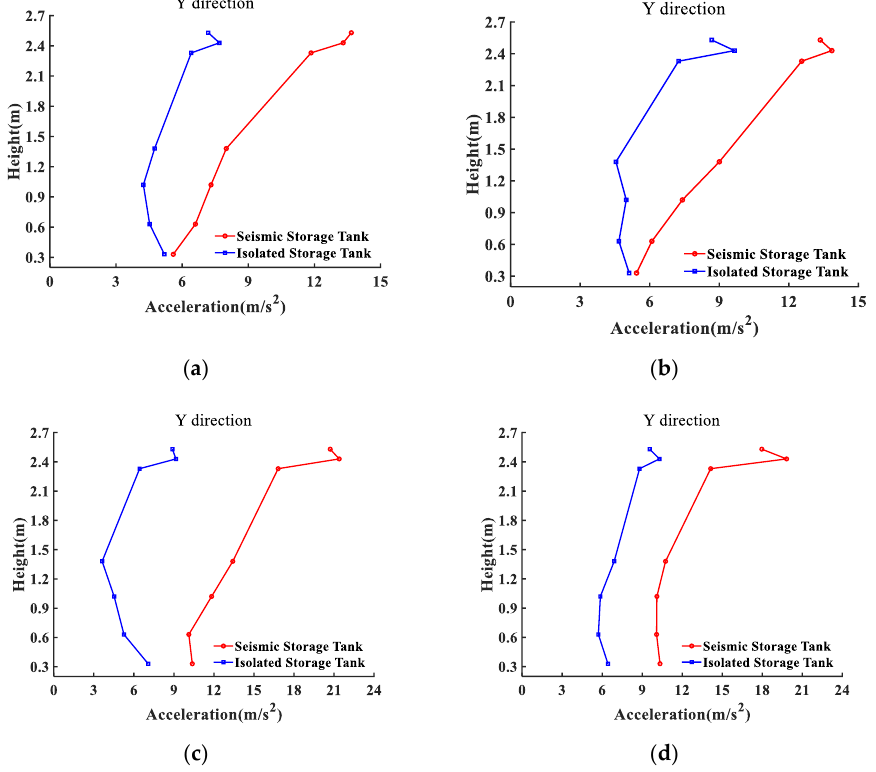
Figure 5. Comparison of peak acceleration in the X direction of the isolation storage tank: ( a ) Taft wave (XZ direction, 0.50 g); ( b ) Artificial wave (XYZ direction, 0.50 g); ( c ) Wolong wave (XYZ direction, 0.75 g); ( d ) Taft wave (XZ direction, 0.75 g).